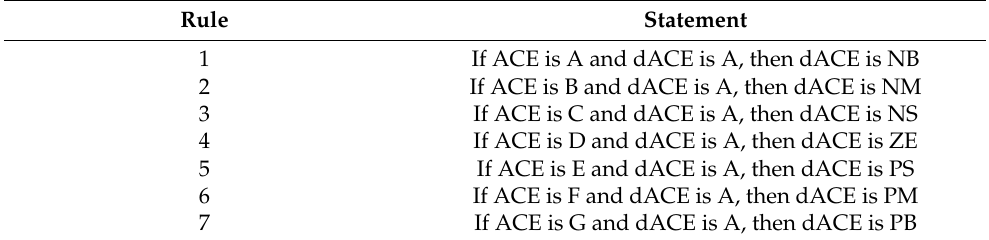
Table 2. Rule base